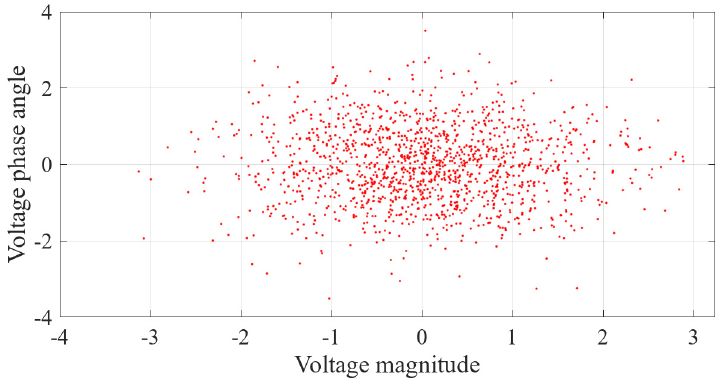
Figure 19. Errors of the state estimation under normal conditions.